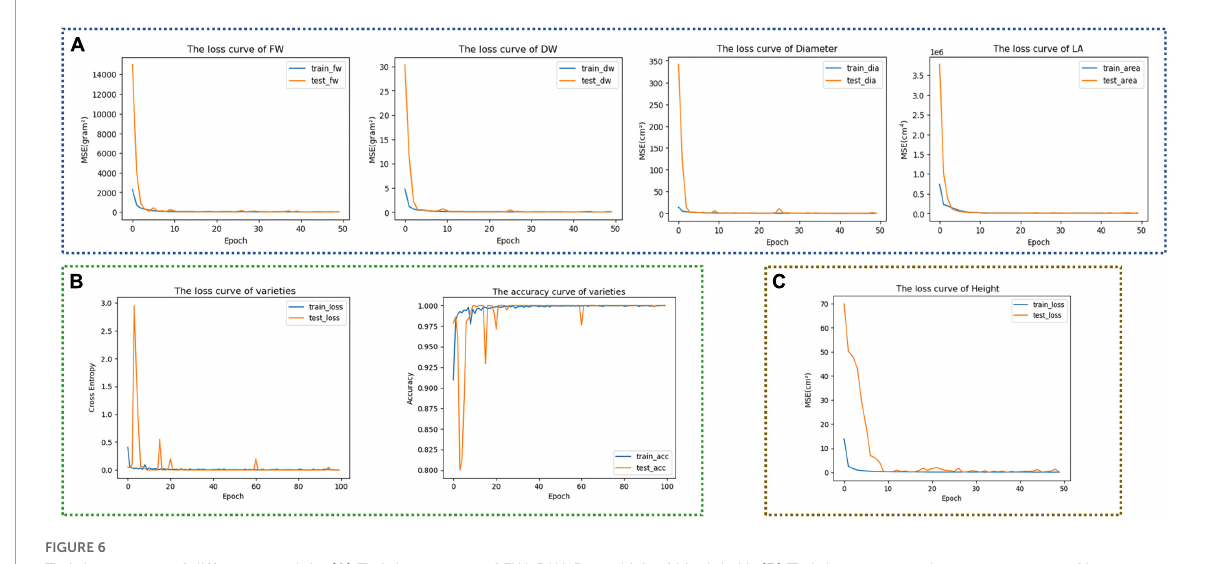
FIGURE6 Training curves of different models. (A) Training curves of FW, DW, D, and LA of Model_11. (B) Training curve and accuracy curve of lettuce varieties of Model_12. (C) Training curve of H of Model_13.